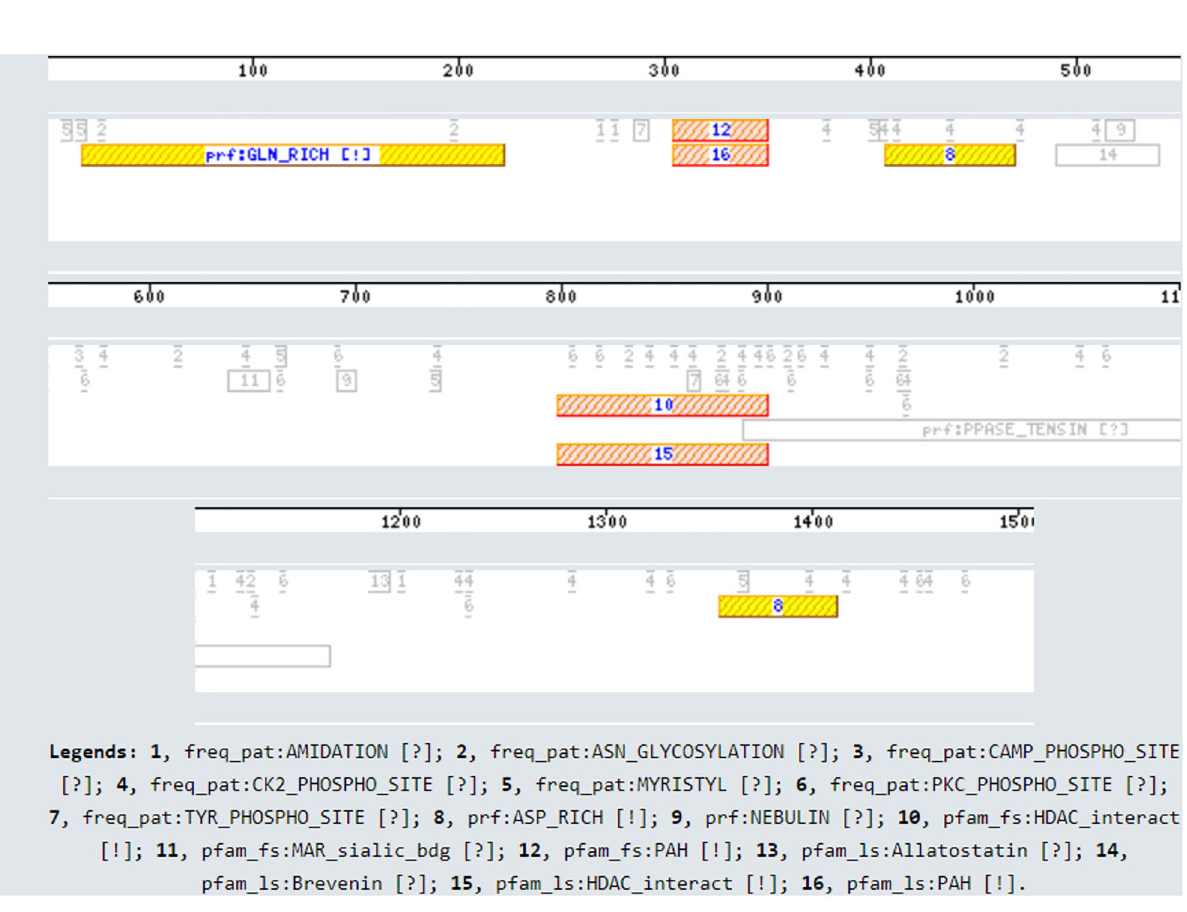
Figure 3. Schematic representation of motifs in Caenorhabditis elegans SIN-3 protein. Motif Scan 105 was used for finding all the known motifs that occur in the protein sequence of SIN-3 protein using HAMAP profiles [hamap], PROSITE patterns [pat], PROSITE patterns (frequent match producers) [freq_pat], Pfam HMMs (global models) [pfam_ls], Pfam HMMs (local models) [pfam_fs], PROSITE profiles [prf], More profiles [pre]. The legends at the bottom of the figure are provided for the key to the numbering of the protein domains/motifs. [!] represents a strong match (low likelihood of a false positive) while [?] represents a questionable or weak match (additional biological evidences are required for true/false negative